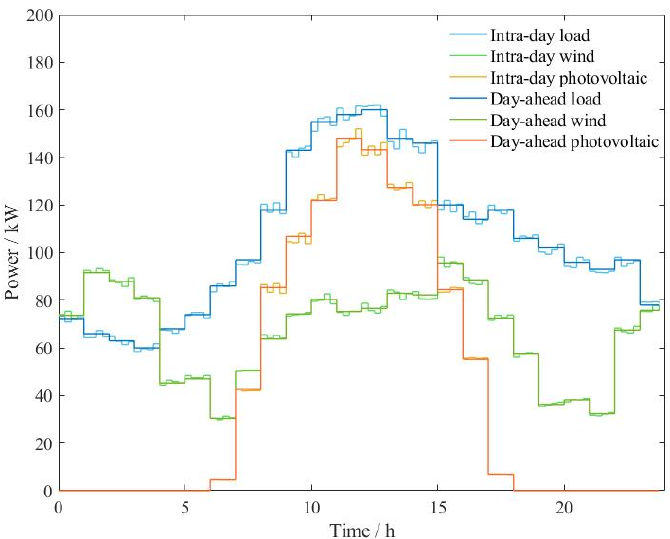
Figure 9. Intra ‐ day short ‐ term forecast result. Figure 9. Intra-day short-term forecast result.